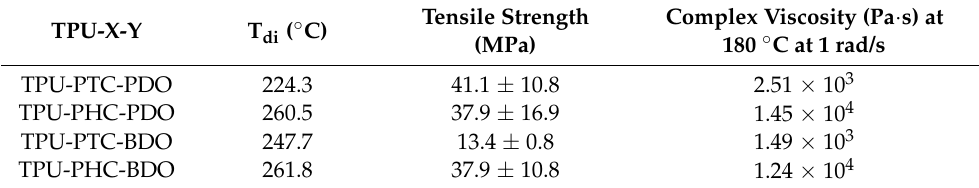
Table 7. TPU main results and